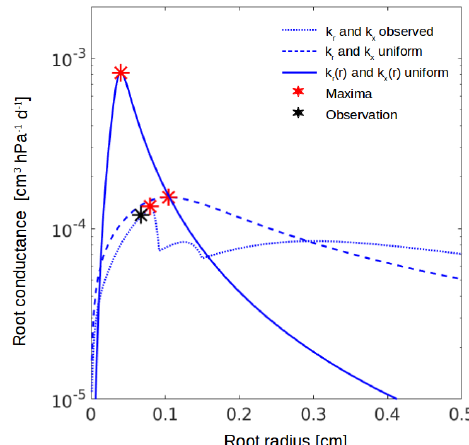
Figure 11. Effective conductance as a function of root radius under a volume constraint for a uniform root whose hydraulic properties depend on the root radius (solid line), a uniform root (dashed line) and a root with observed heterogeneous conductivity profiles (dot- ted line). The red stars denote the optimal radii (i.e. that maximize the effective conductance), the black star the observed